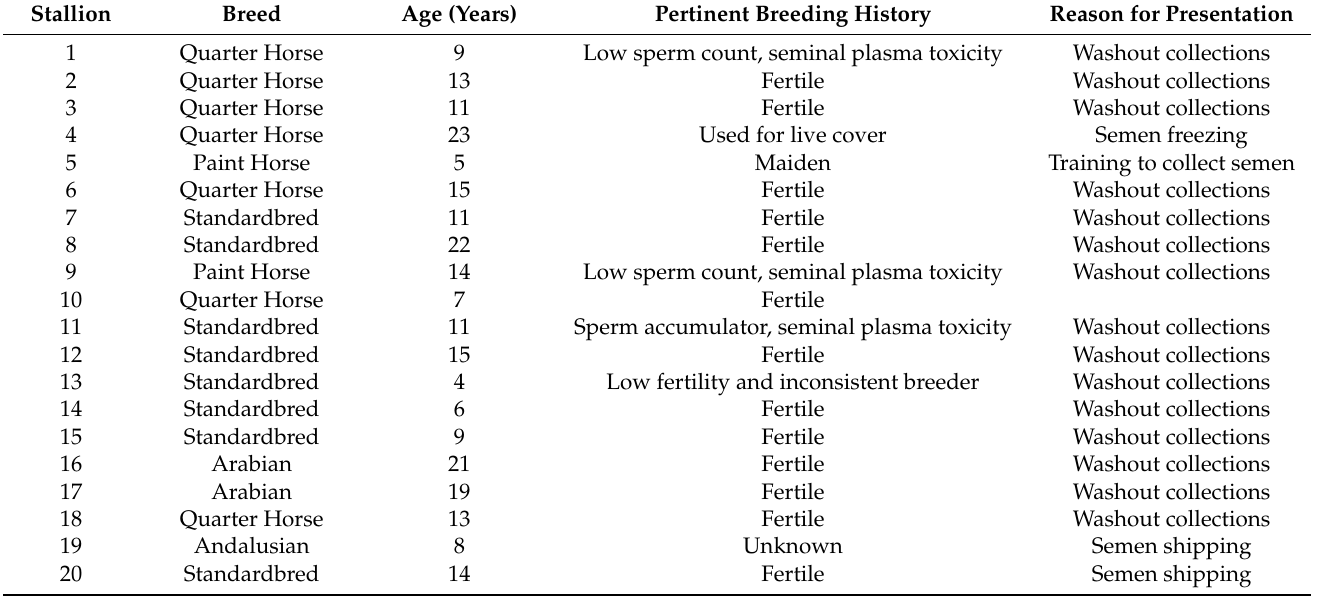
Table 1. Signalment, history, and reason for the presentation of the 20 breeding inactive